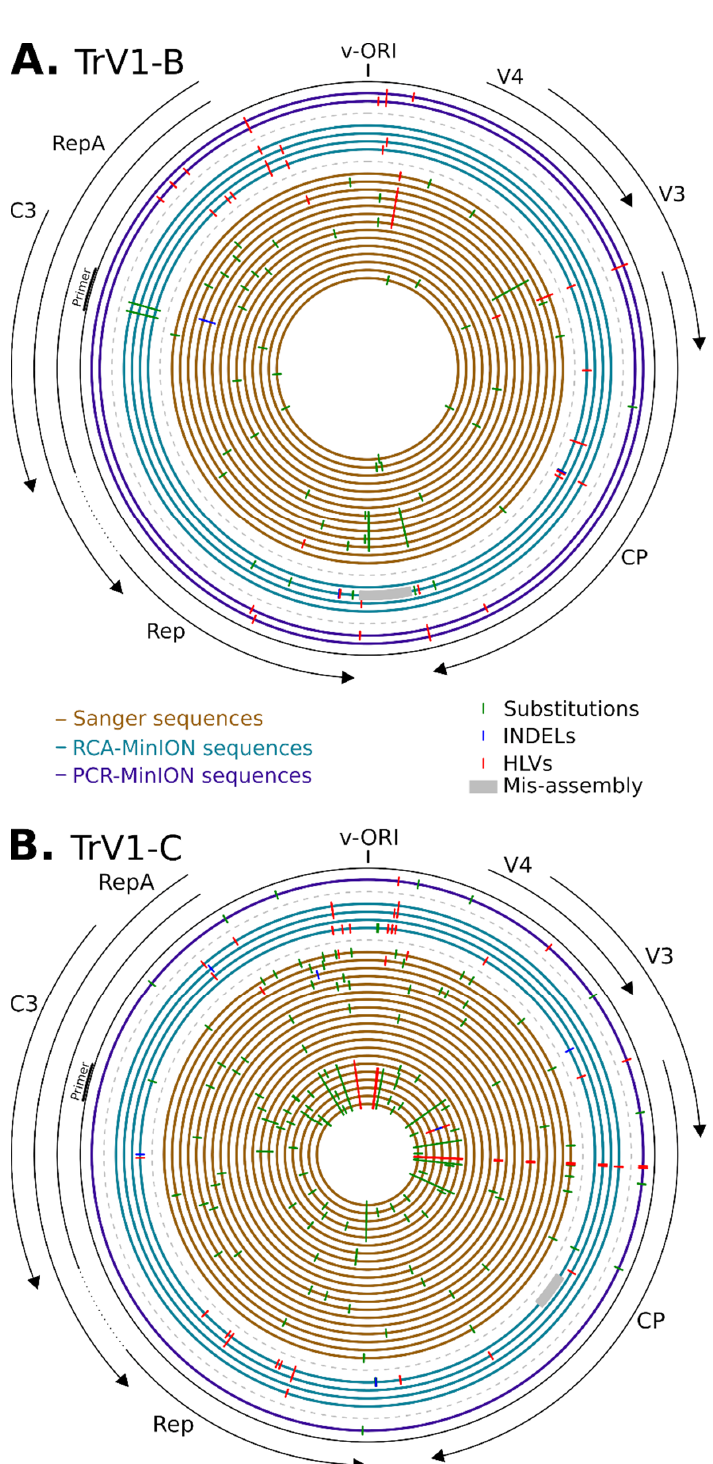
Figure 3. Diagram presenting the positions of the mutations along the genome of the TrV1-B ( A ) and TrV1-C ( B ) isolates and assemblies. Concentric circles represent each complete genome sequence obtained, with from the center to the outer, Sanger sequences in brown, RCA-MinION in blue and PCR-MinION in purple. Substitutions, INDELs and homopolymer length variations are represented with green, blue and red ticks respectively. Grey areas represent large deletions. Positions are relative to reference sequences MW698819 for TrV1-B and MW698820 for TrV1-C. The origin of replication (v-ORI) is indicated on top and the ORFs are represented on the outside of the